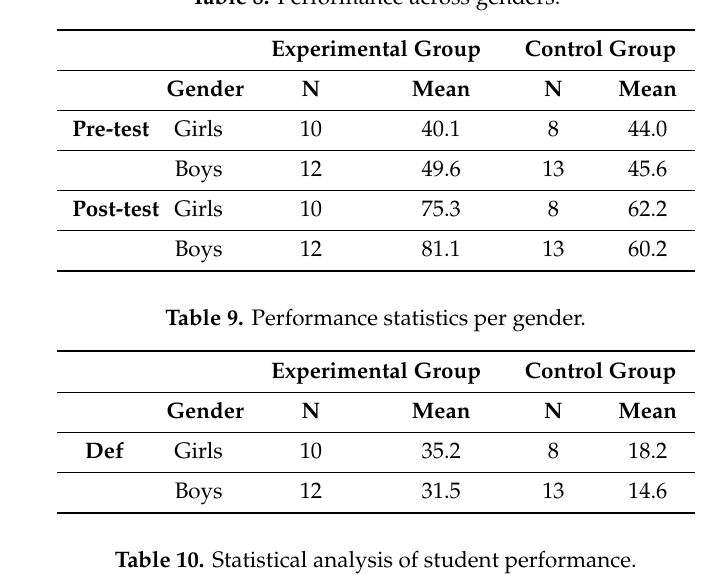
Table 8. Performance across genders.